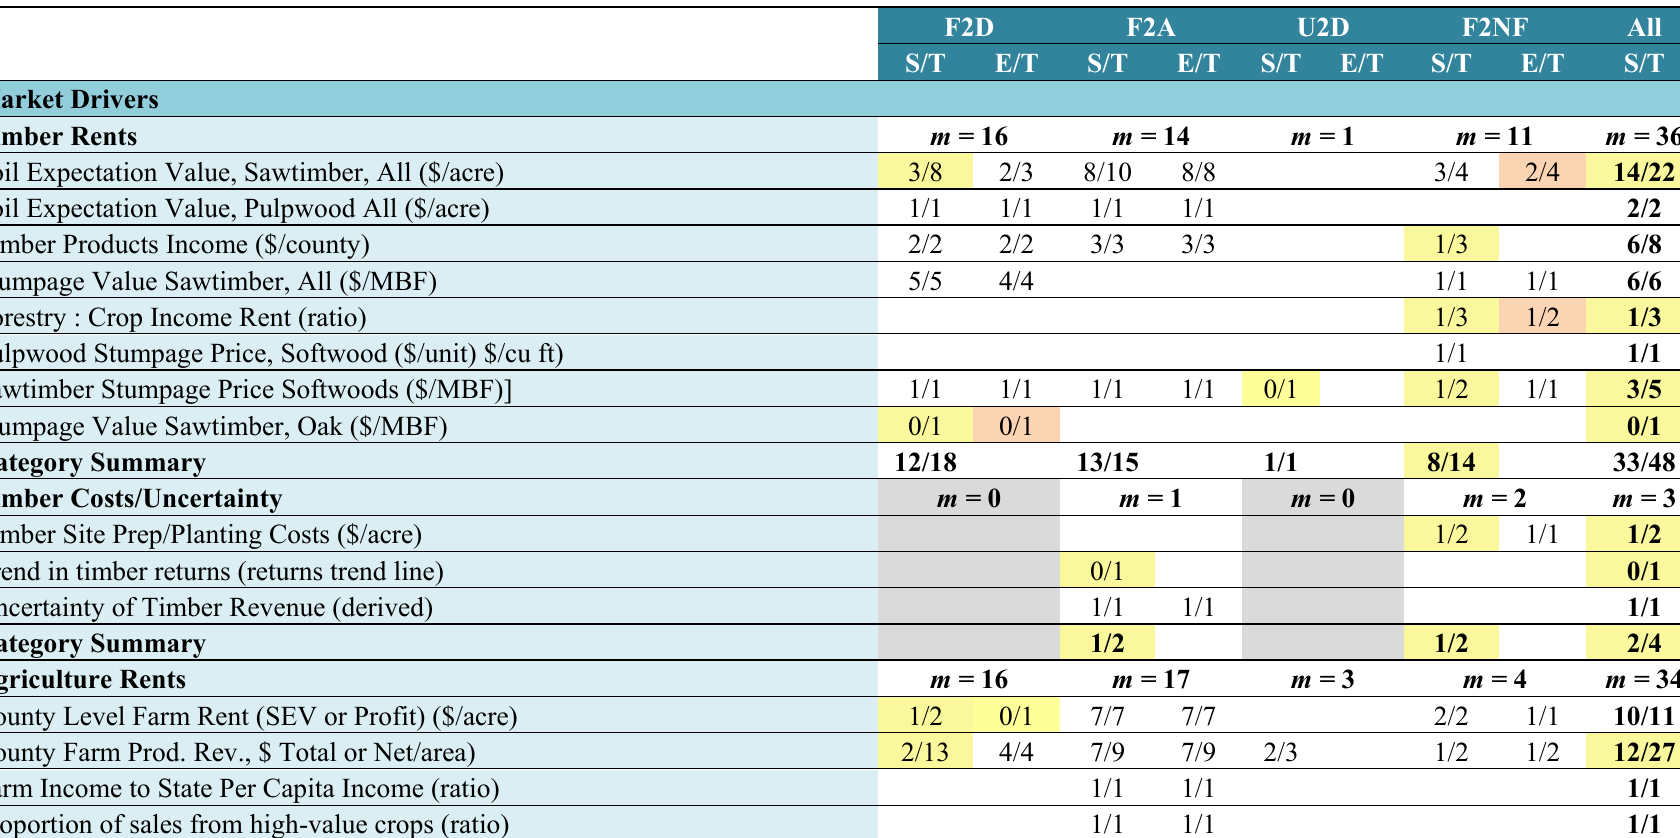
Table 4. Vote count meta-analysis summary of independent variables used in 47 econometric studies that estimated forest land loss through 4 model types: forest to development models (F2D), forest to agriculture models (F2A), undeveloped to developed models (U2D), and forested to non-forested models